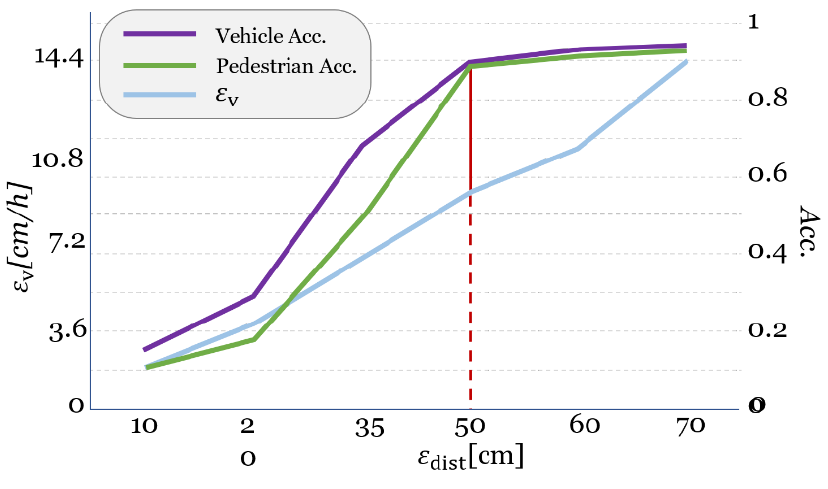
Figure 13. Plots for accuracies and ε v by ε dist